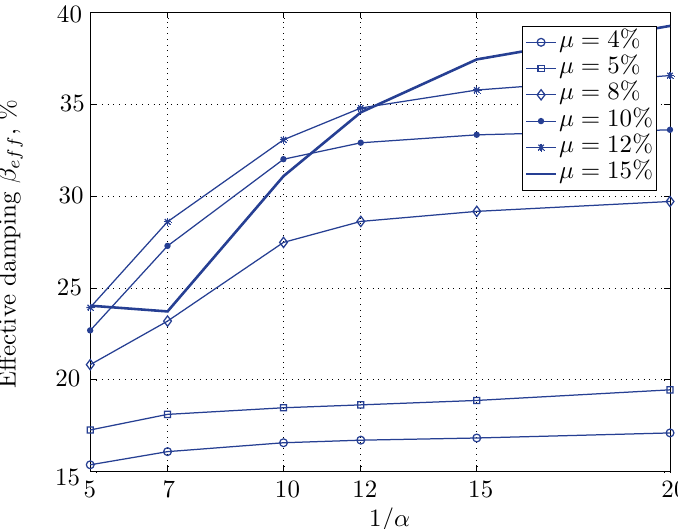
Figure 44. Effective damping for various isolation system parameters (Yermo).